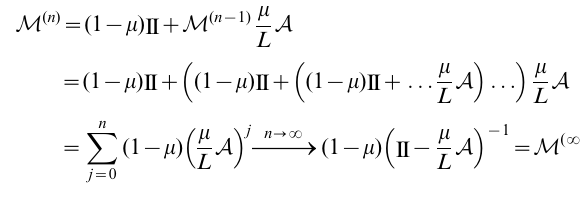
Figure S1 Comparison of D w ( t ) , P adv ( t ) and the frequency of recombining individuals for the case with a modifier allele F rec as quantifiers for the (dis-)advantage of recombination.